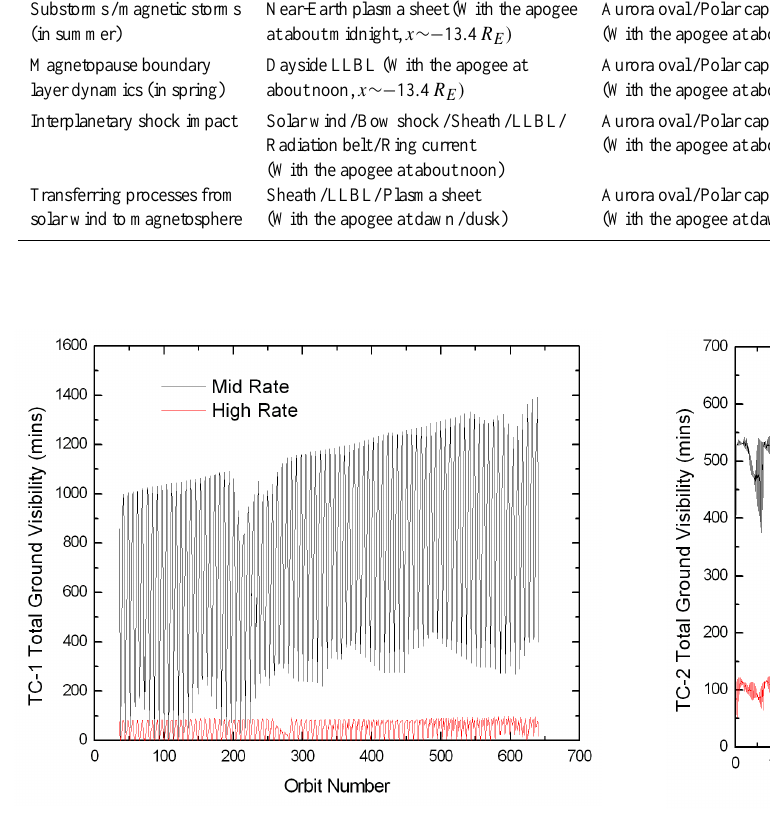
Fig. 6. TC-1 satellite total visibility at high and mid data dumping rates from the three ground stations.